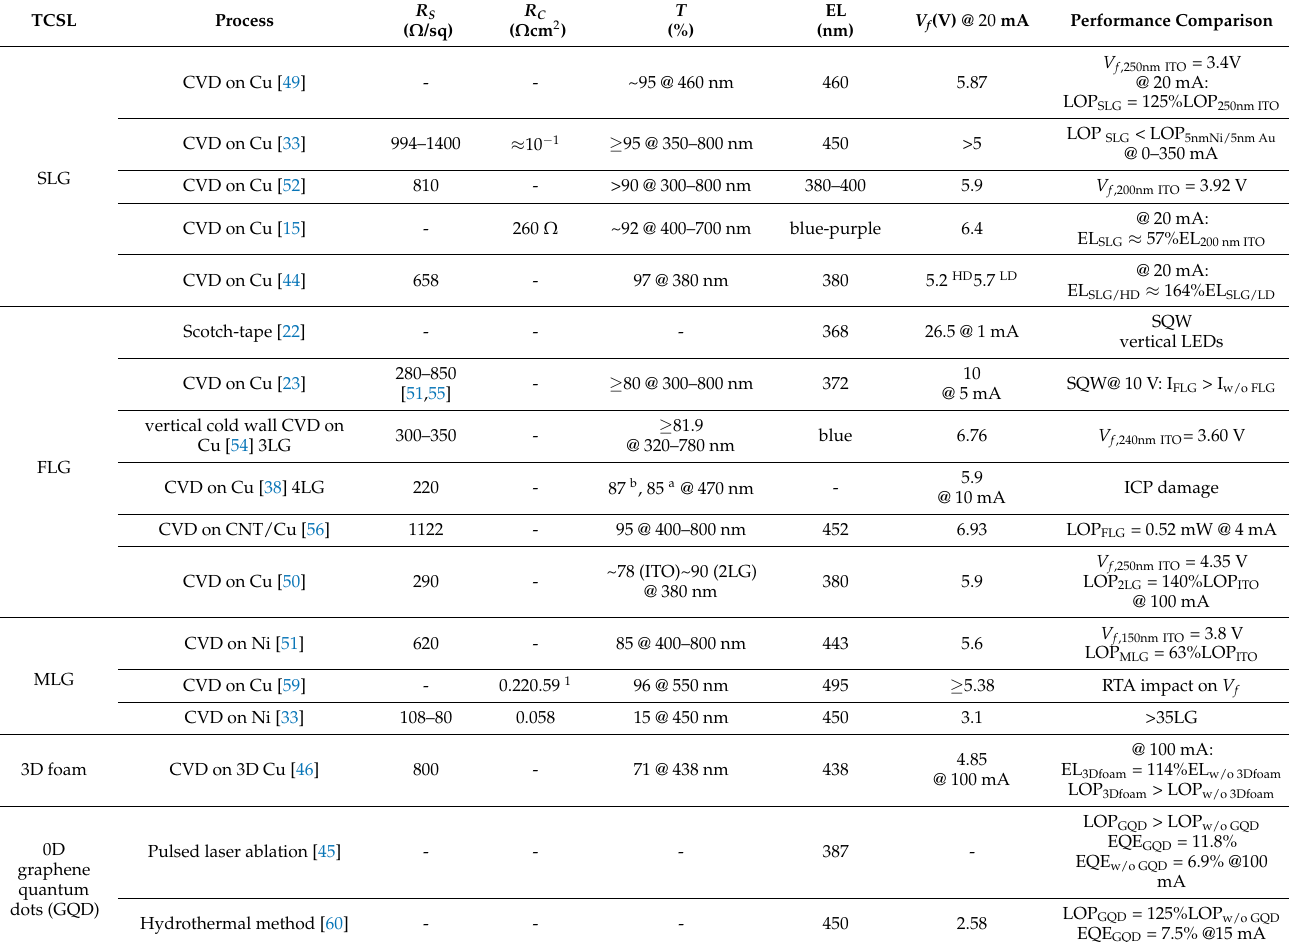
Table 1. Usage of transferred single layer (SLG), few-layer (FLG) and multilayer (MLG) graphene TCSLs in GaN-based LEDs. Transmittance values of TCSLs are measured at (@) a certain wavelength or in a spectral range, and the electrical parameters are measured at (@) a certain input